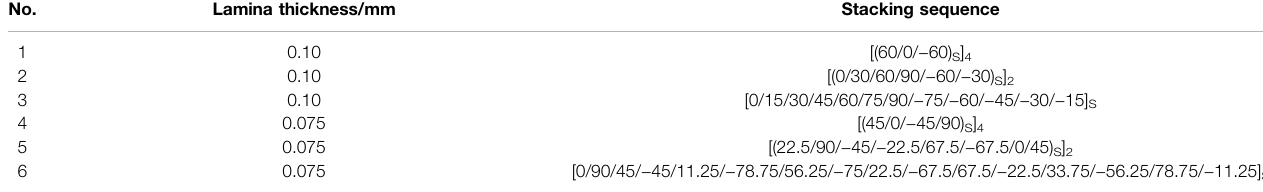
TABLE 2 | Typical stacking sequences.